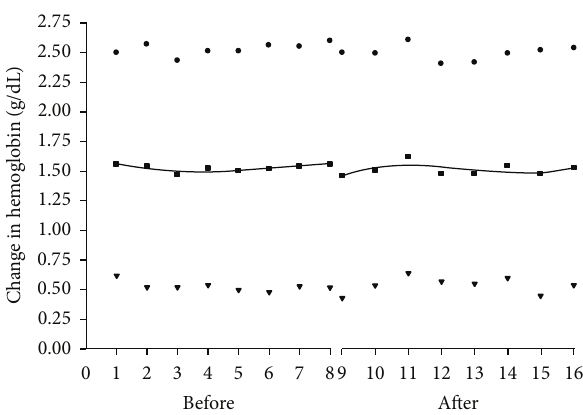
Figure 1: Mean hemoglobin (g/dL) change (squares) pre (months 1– 8) and post (months 9–16). Two standard deviations above (circles) andbelow(triangles). Thecurveforthemeanhemoglobinisthebest fit third-degree